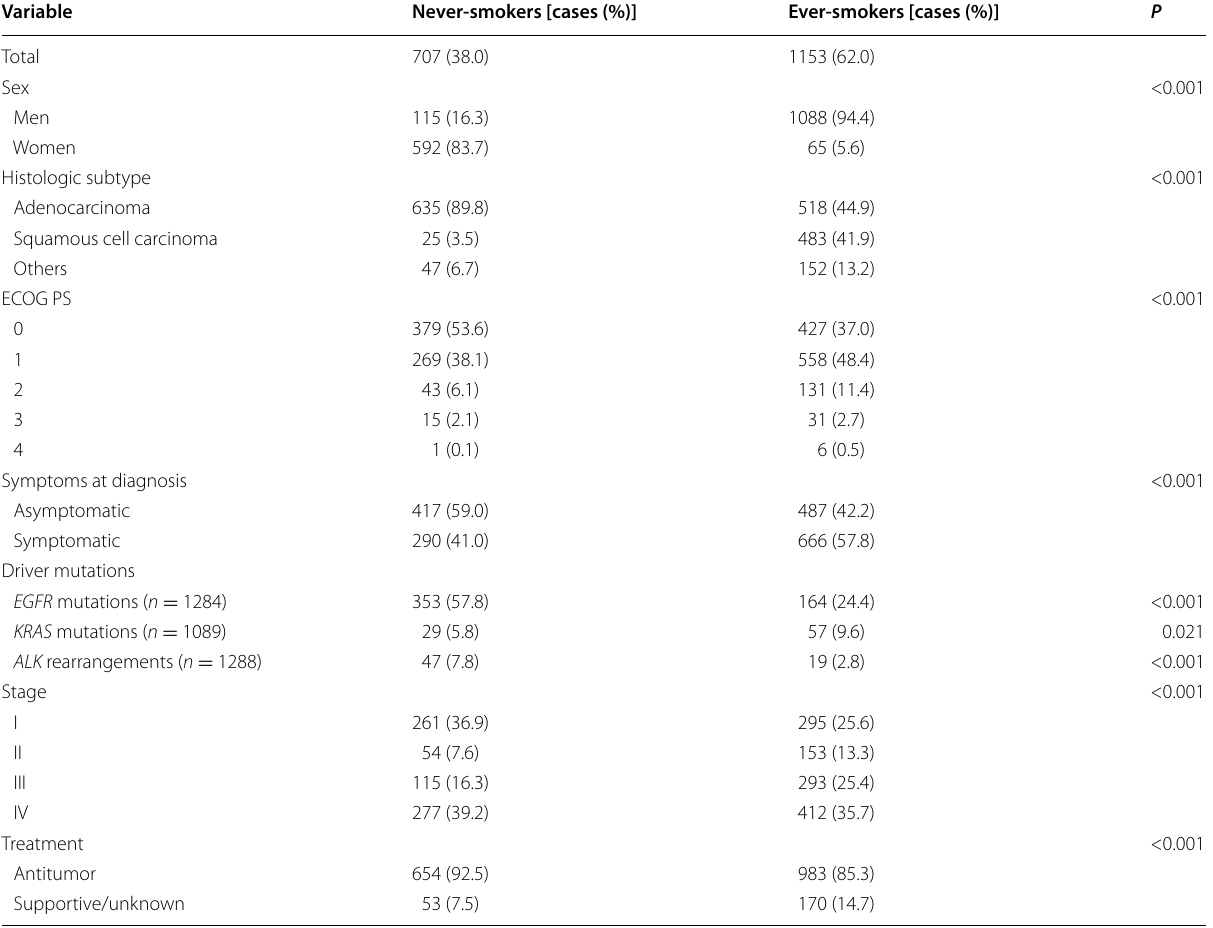
Table 1 Characteristics of 1860 patients with NSCLC according to smoking